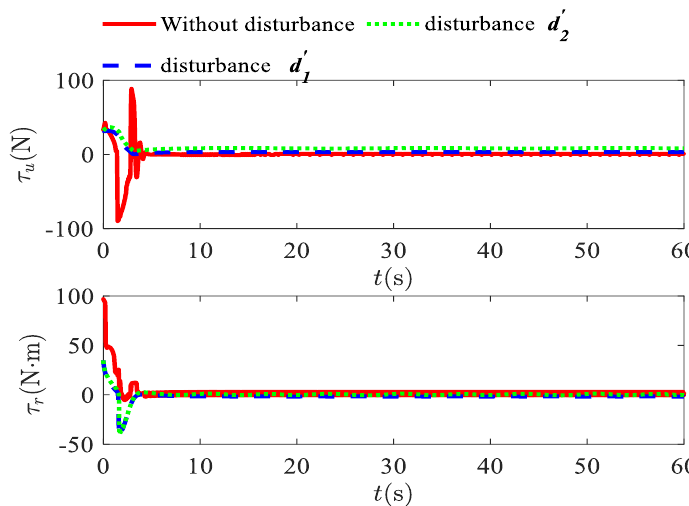
Figure 4. Position and velocity curves: ( a ) the actual position of USV in three cases; ( b ) the actual velocity of USV in three cases; ( c ) position tracking errors in three cases; ( d ) velocity tracking errors in three cases.